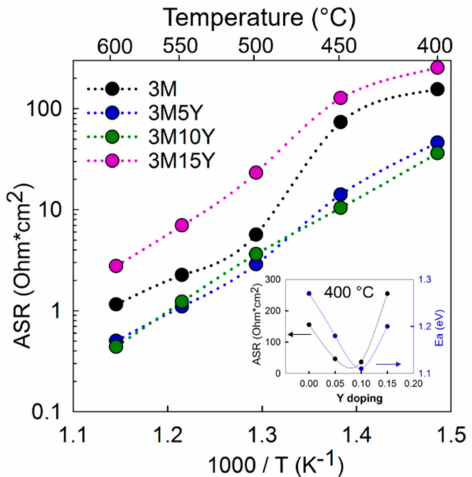
Figure 7. Total area specific resistance (ASR) of 3M, 3M5Y, 3M10Y, and 3M15Y composite cathodes in symmetric cell configuration in 3% moist synthetic air as a function of temperature. Inset shows the relationship of the ASR at 400 ◦ C and Ea with respect to the Y content. Lines are a guide for the